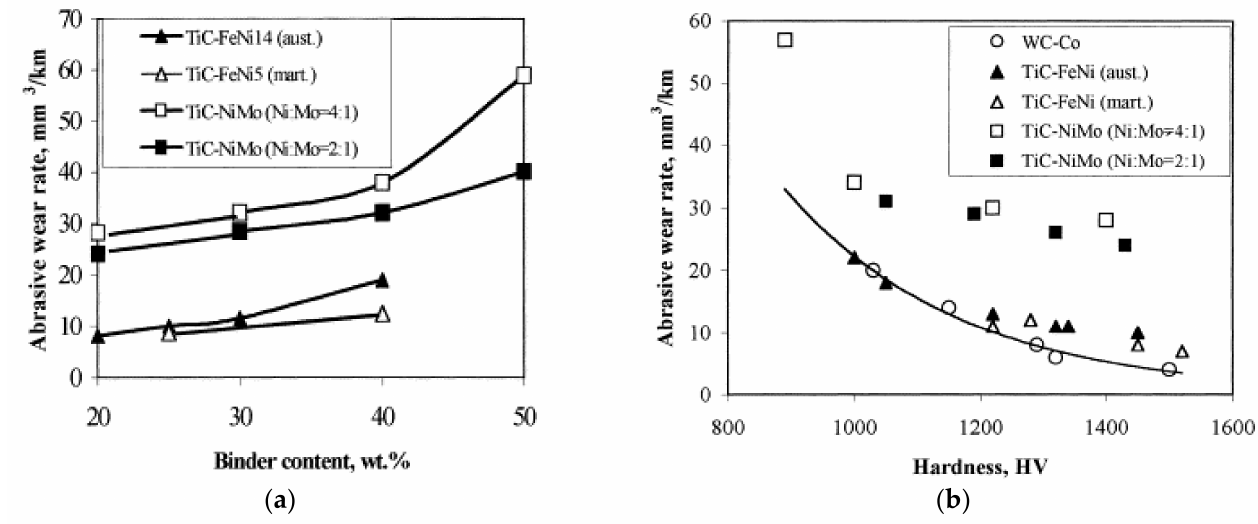
Figure 6. Abrasive wear rate of TiC-NiMo and TiC-FeNi cermets vs. binder content, NiMo ratio and structure ( a ) and Vickers hardness ( b )